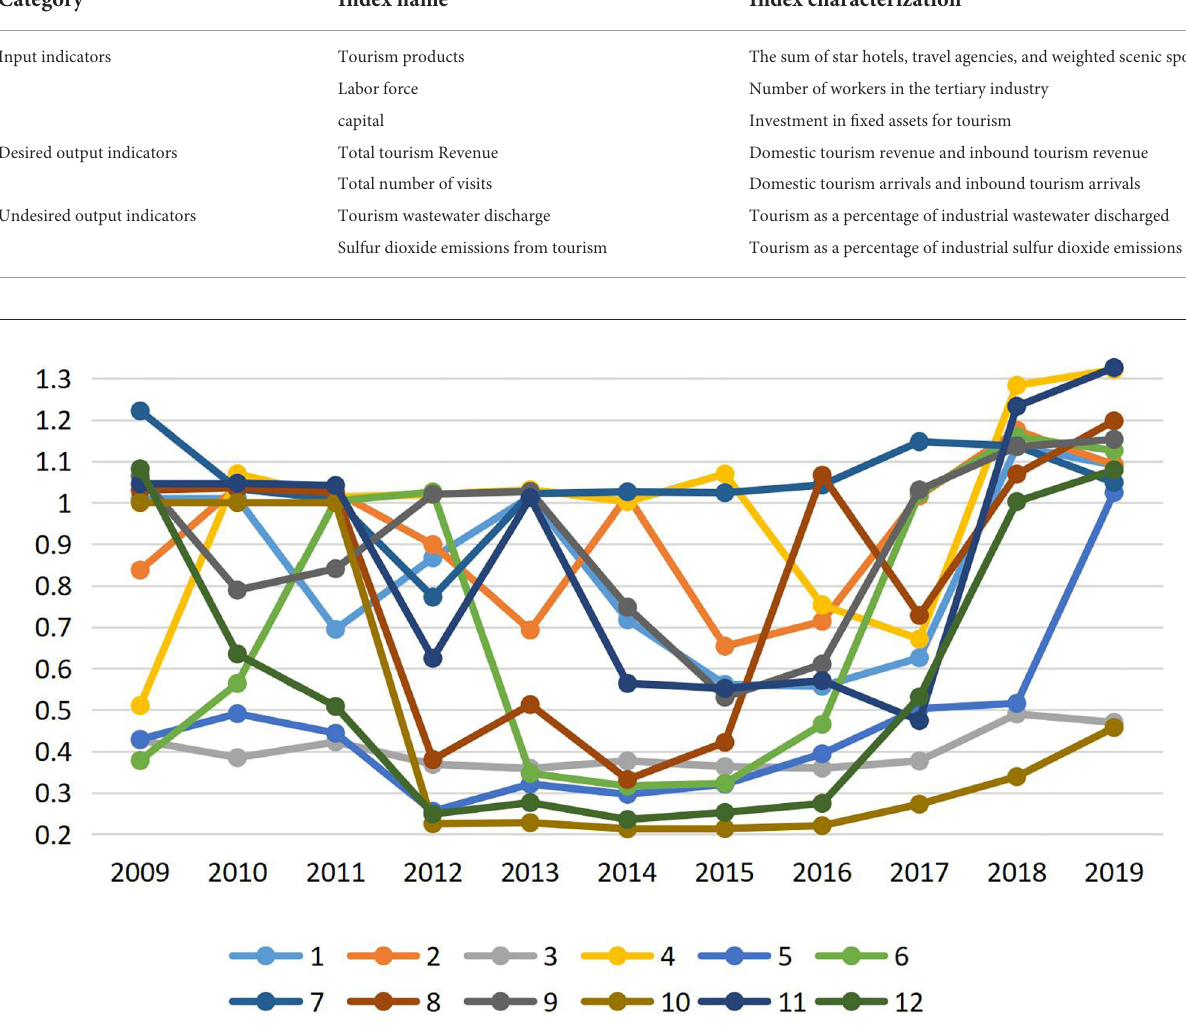
Y ( x i ) and Y ( x i + k ) are the observed values Y ( x ) of the geographic variables at the points x i and x i + k , N ( k ) are the sample sizes of the k segmentation